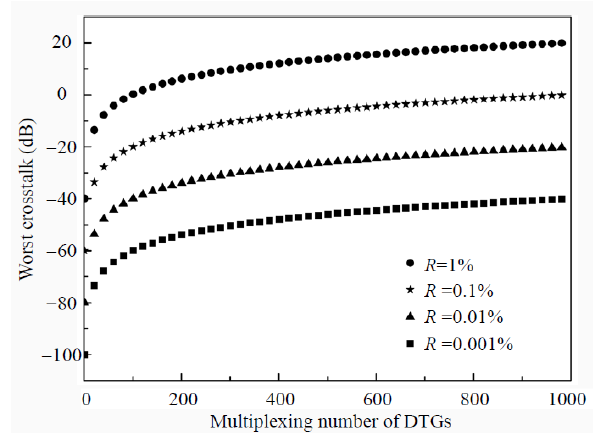
Fig. 4 Crosstalk verses the multiplexing number of DTG at different